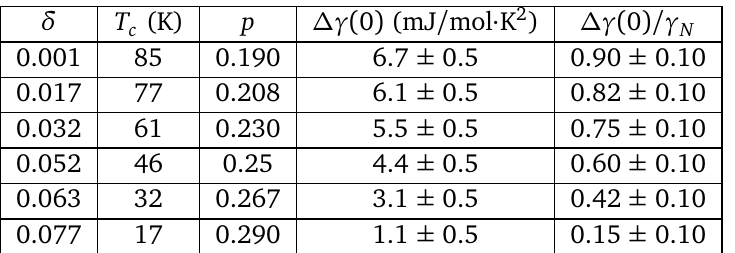
Table 6: Tight-binding parameters for La